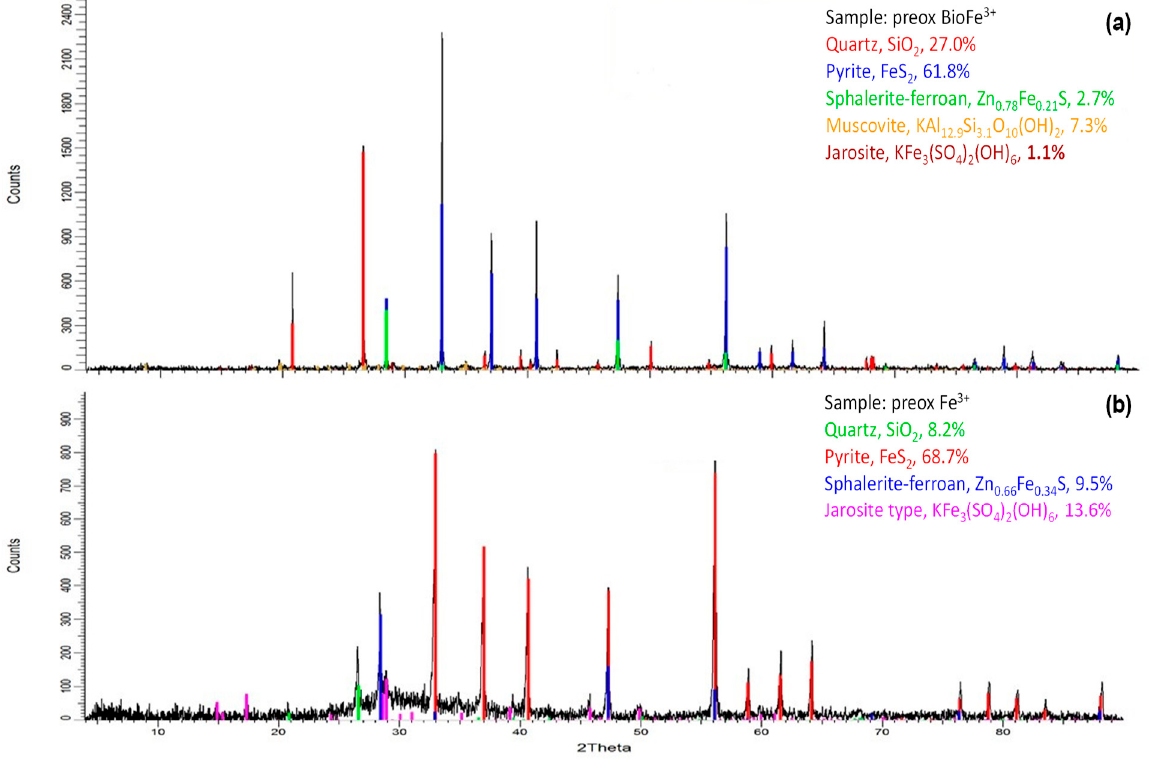
Figure 4. XRD results of precipitates obtained after preoxidation of the FeS 2 concentrate with ( a ) BioFe 3+ and ( b ) Fe 3+ at 30 °C. Note: Different color codes were used in ( a ) and ( b ) for the minerals; e.g., FeS 2 is shown in blue in ( a ) but in red in ( b ).